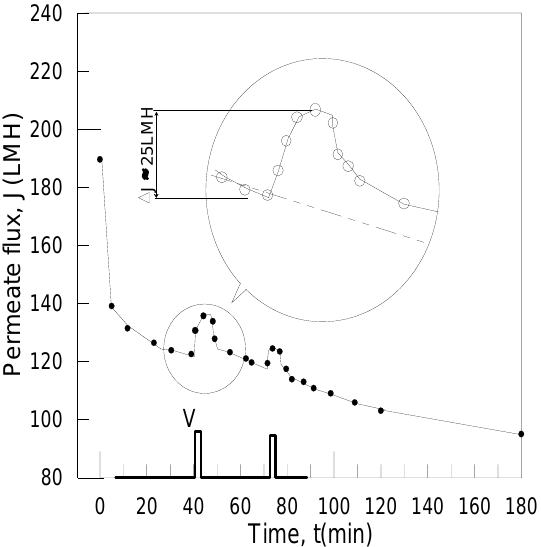
Figure 6. The EMF flux gain of Alamin ( Δ J) when electric field was been applied. Membrane pore size: 0.5 µm, pH = 7; Δ P 180 V/cm; Current I = 63 A/m 2